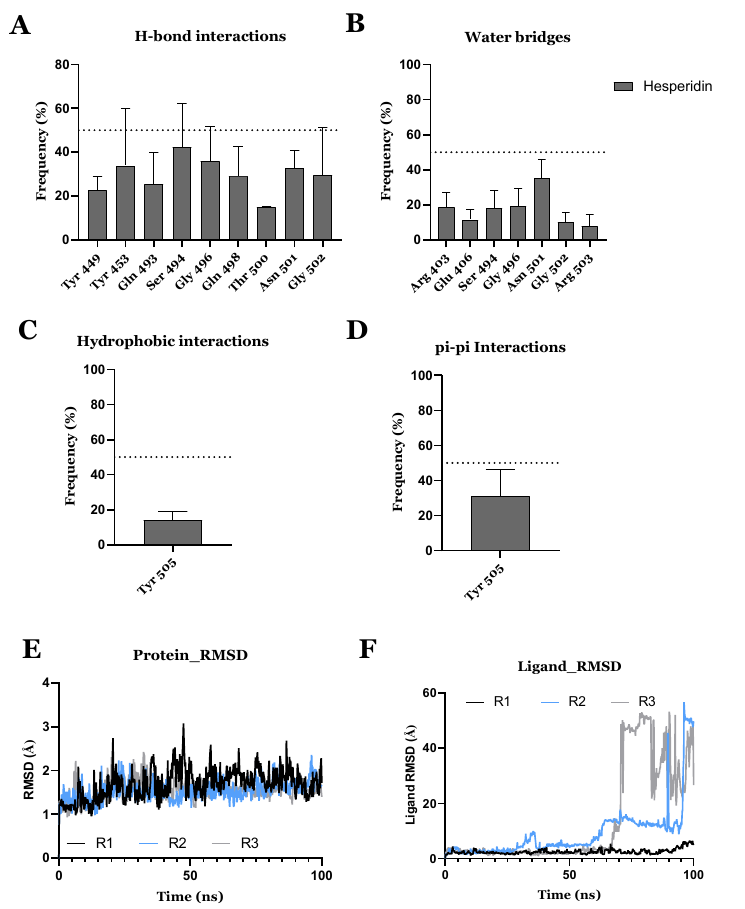
Figure 5. Hesperidin protein–ligand interaction along the 100 ns simulation. Frequency of hydrogen bonding interactions ( A ); water-mediated hydrogen bonding interactions ( B ); hydrophobic interac- tions ( C ); π - π interactions ( D ); representative picture of root mean square deviation (RMSD) values of protein backbone for the protein–hesperidin complexes ( E ); Ligand RMSD variation along the simulation time for viomycin ( F ).